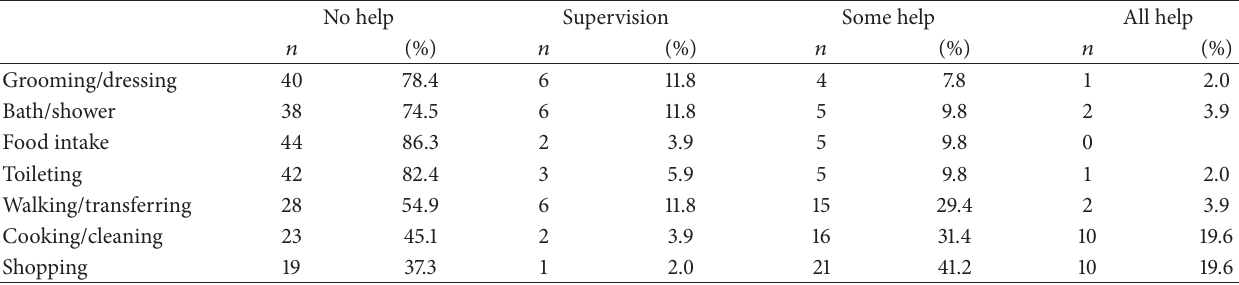
Table 3: Frequency of PD-patients ∗ who need help in different daily activities. 𝑛 = 51 .